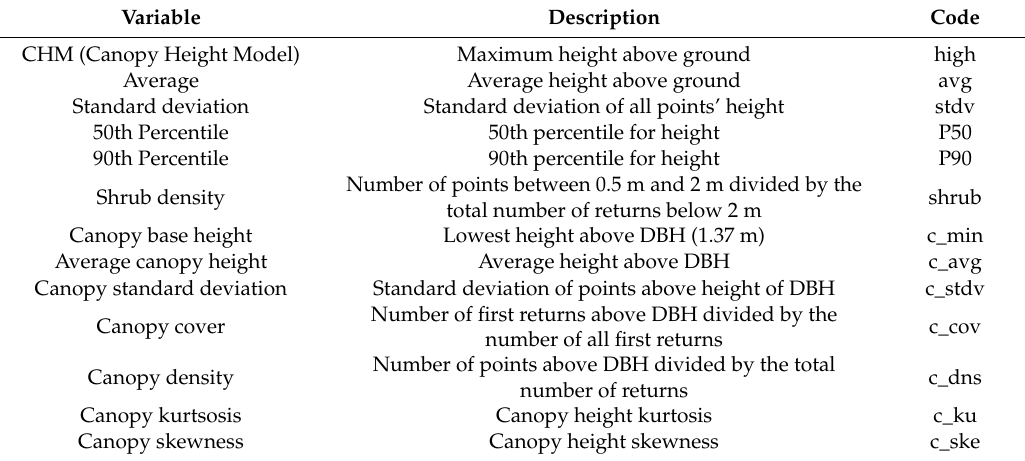
Table 2. Calculated LiDAR